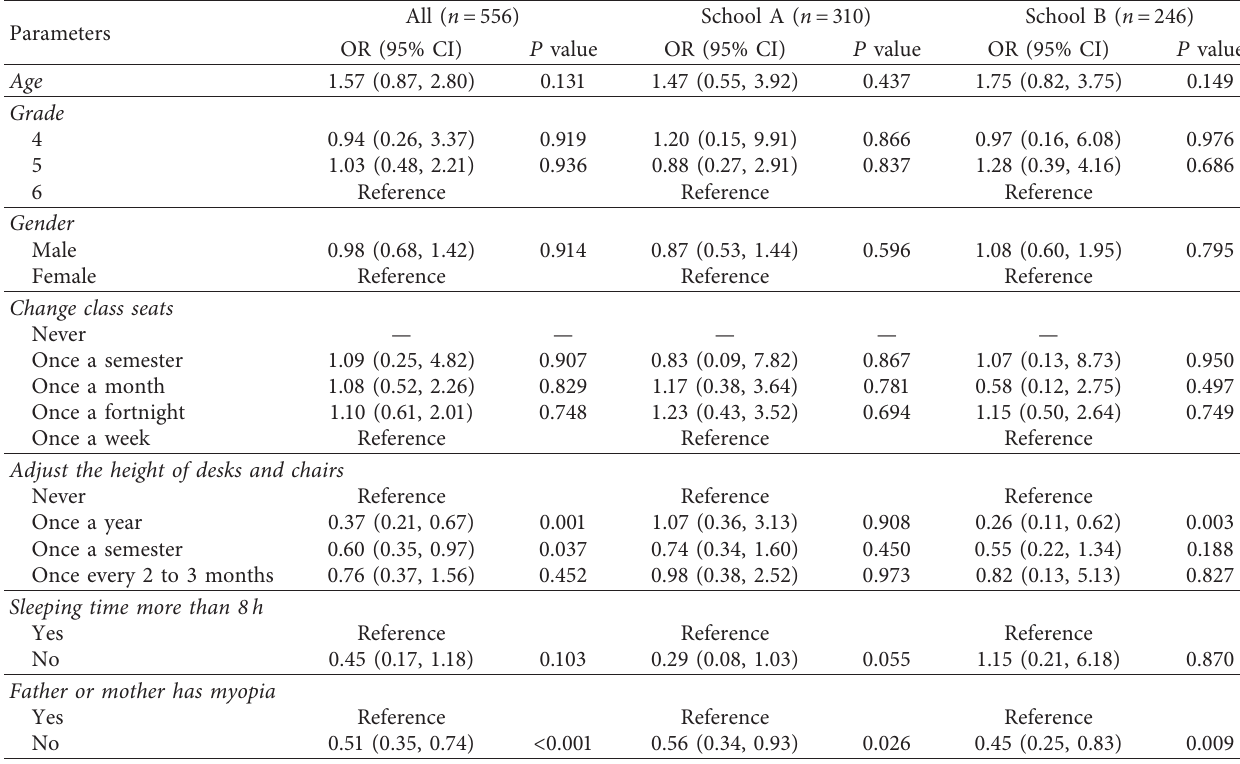
Table 3: The associations between factors and myopia using multivariate logistic